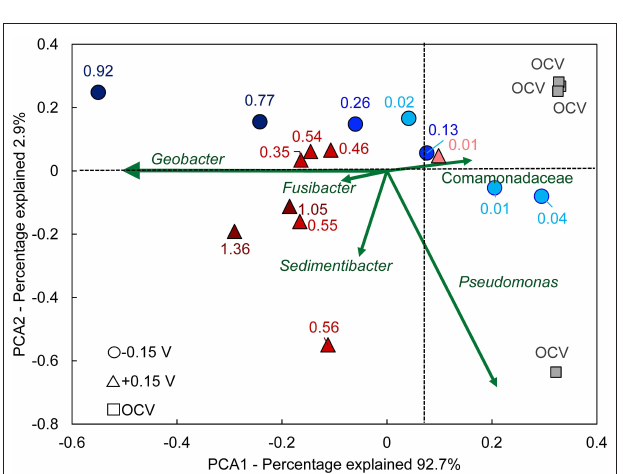
FIGURE 7 | Principal component analysis (PCA) biplot of anode biofilm microbial communities. Points with the same shape represent replicate bioanodes fixed at − 0.15V (circles) and + 0.15V (triangles). The points are shaded to reflect bioanode activity level (dark, high-activity; medium, low-activity; light, inactive). The numbers next to each curve are the current density recorded at the end of the startup period. Green vectors symbolize the eigenvector of the corresponding genus. Samples that are located in the direction of an eigenvector contain that particular genus, with an increased relative abundance the farther they are located from the center. OCV, open circuit voltage bioanodes (squares).